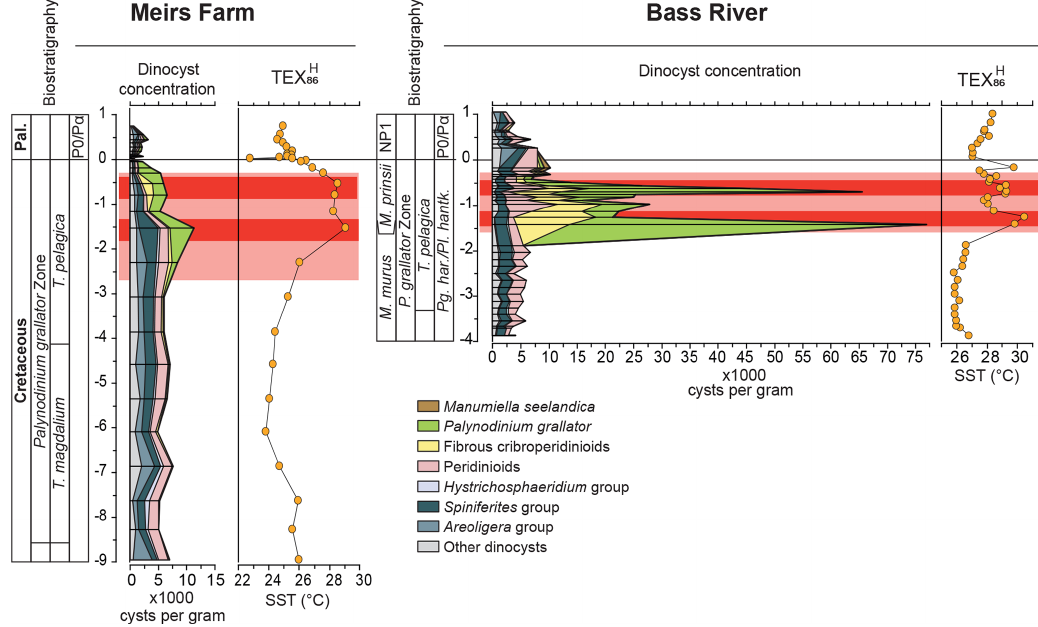
Figure 4. TEX 86 SST records and concentrations of dinocysts for Meirs Farm and Bass River. Dinocyst concentrations in cysts per gram of dry sediment. For the raw data, see Tables S4 and S5. M. – Micula ; Pg. har. – Pseudoguembelina hariiaensis ; Pl. hantk. – Plummerita hantkeninoides . For other abbreviations, see Fig.